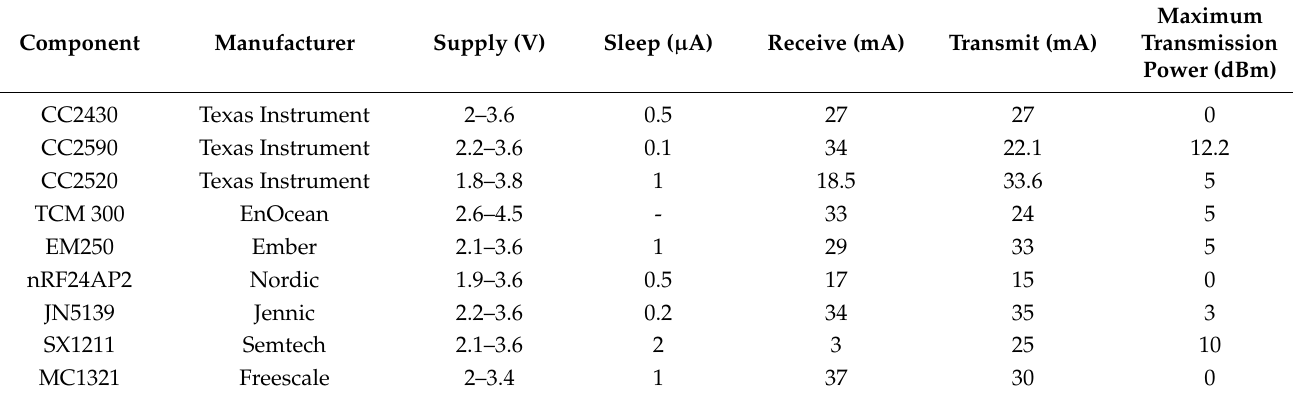
Table 6. Features of some commercial radio chip for